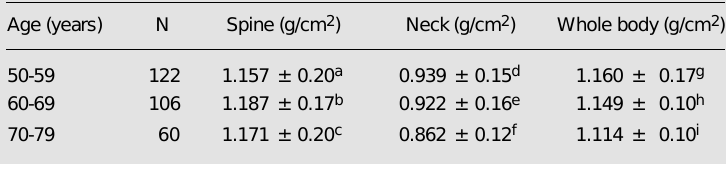
Table 5 - Mean bone mineral density of lumbar spine, femoral neck and whole body of 288 healthy Brazilian men 50 years and older. P<0.05 for d x f, e x f, g x i, and h x i (Kruskal-Wallis test with